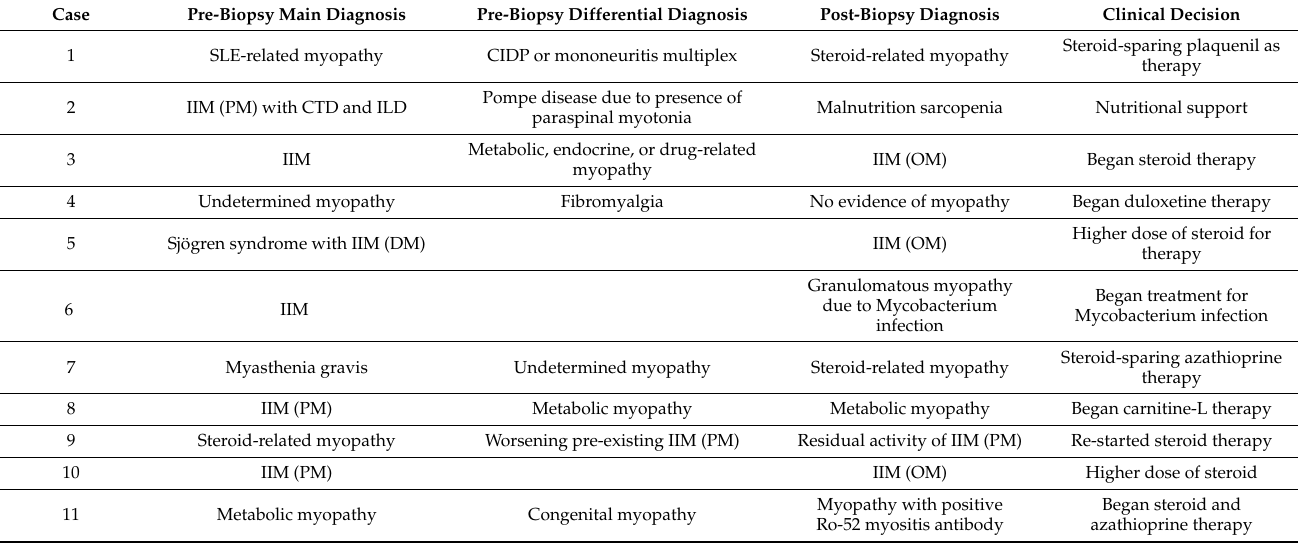
Table 3. A list of patients who had both diagnosis and treatment changed after muscle biopsy.